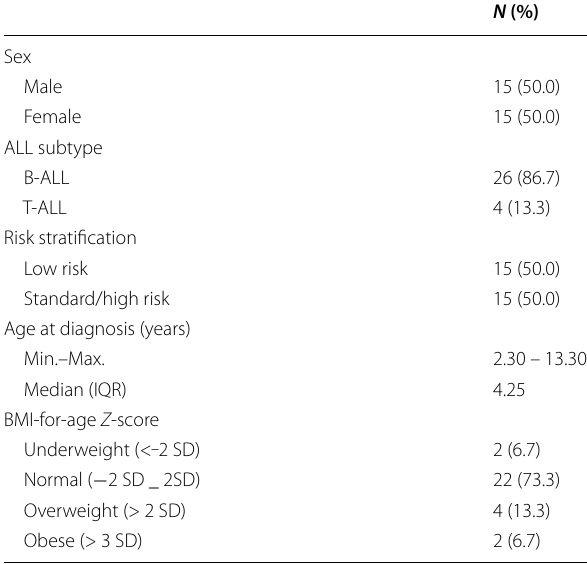
Table 1 Demographic and clinical data of included